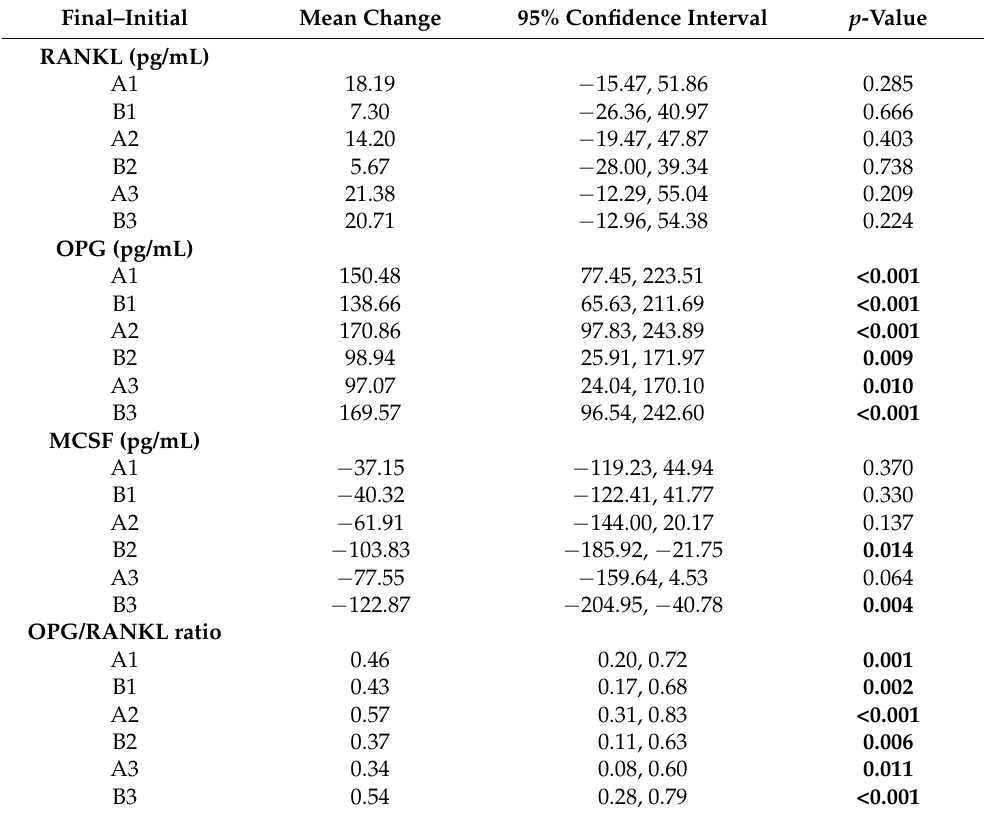
Table 2. Estimated mean changes (final–initial), 95% confidence intervals and p -values (comparing with 0, i.e., no change) per group and